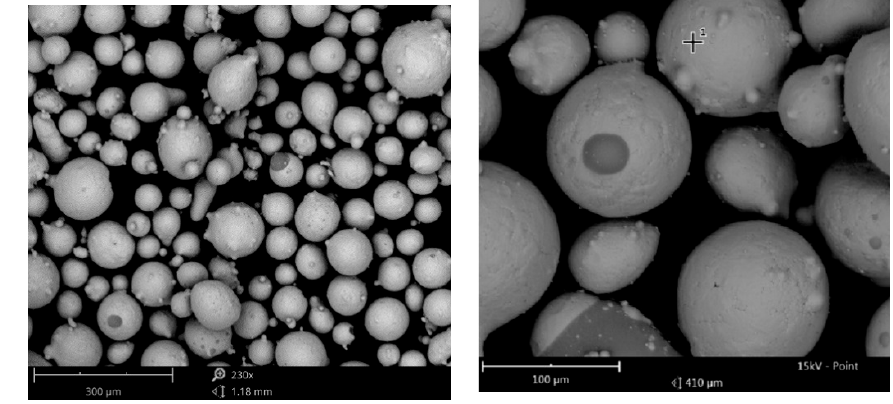
Figure 1. Surface of powder particles 06Cr15Ni4CuMo.